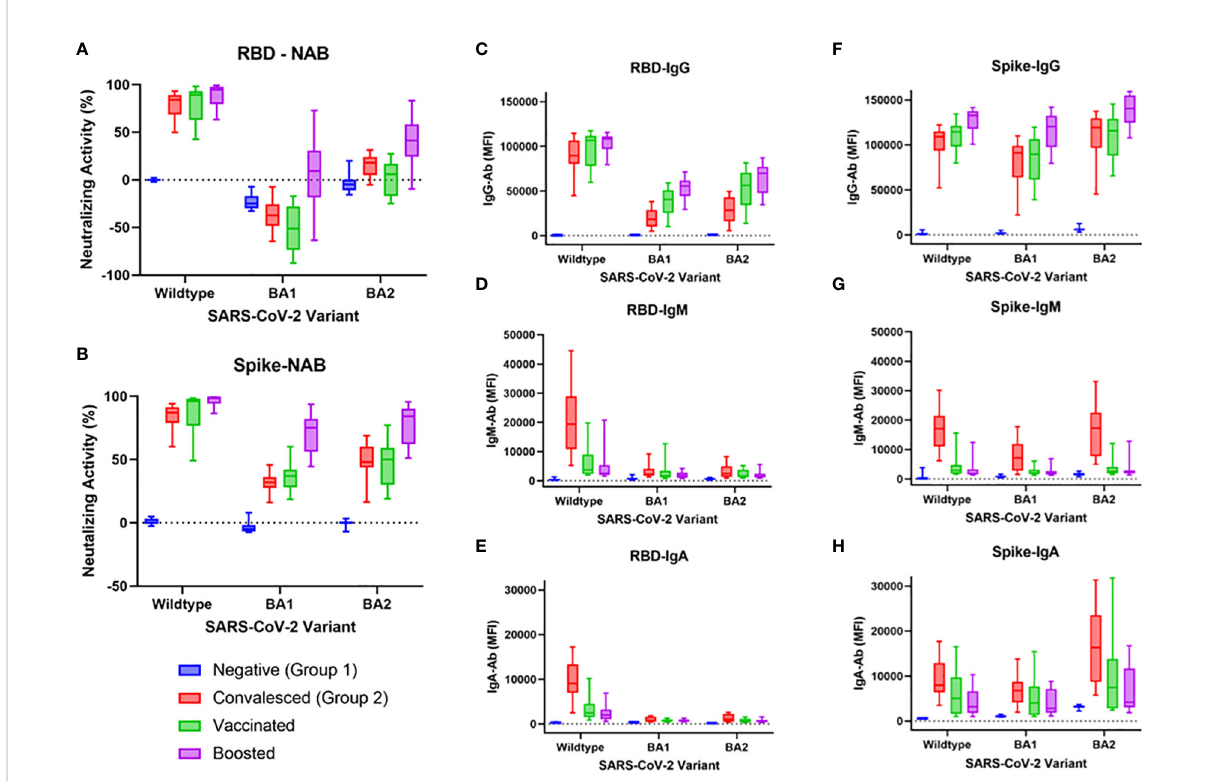
FIGURE 2 NAb activity and IgG, IgM, and IgA antibodies to WT, BA1, or BA2 spike or RBD antigen in negative, convalesced, vaccinated, and boosted subjects. NAbs were signi fi cantly lower for BA1 and BA2 compared to wildtype in convalesced, vaccinated, and boosted groups when either RBD antigen (A) or spike antigen (B) were used. Boosted groups displayed higher cross-neutralization to BA.1 and BA.2 than both convalesced and vaccinated groups (A, B) , though less than to WT. These differences were more pronounced when RBD antigen was used compared to spike, demonstrating greater variant-speci fi city with the RBD beads. IgG levels to spike antigen (F) were higher than those to RBD (C) . IgM (D, G) and IgA (E, H) were highest in the convalesced group (compared to vaccinated or boosted) and were higher to spike BA.1/BA.2 than RBD